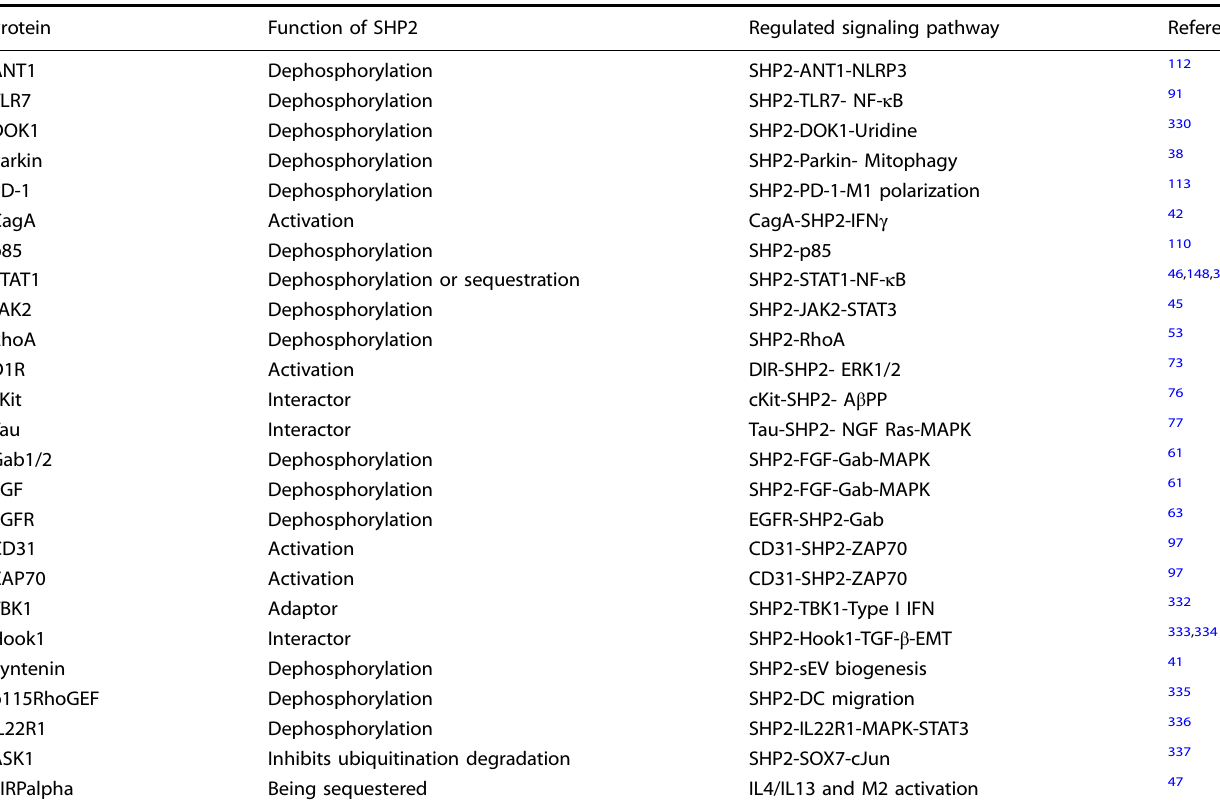
Table 1. Interaction between SHP2 and its binding protein in in fl ammatory diseases Protein Function of SHP2